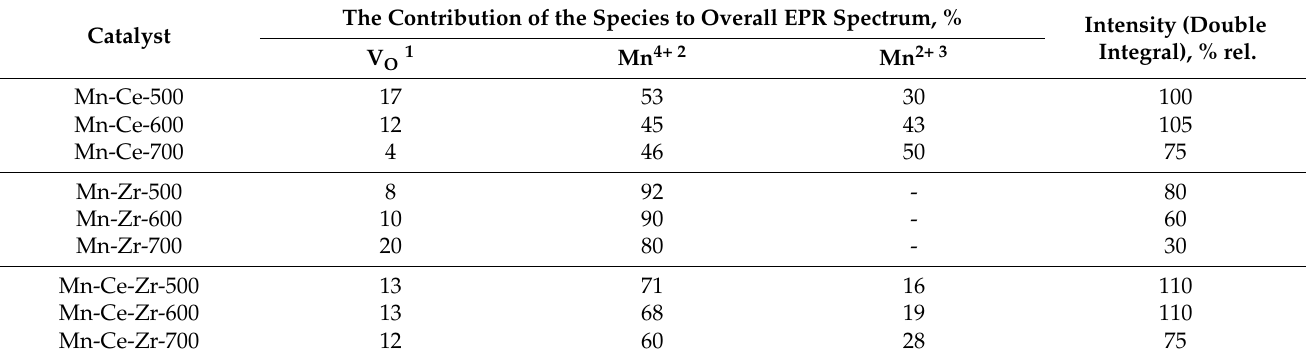
Figure 6. Experimental and simulated EPR spectra of Mn-Ce catalysts, calcined at ( a ) 500 °C, ( b ) 600 °C and ( c ) 700 °C. Different components of the spectra are presented above each simulated curve.